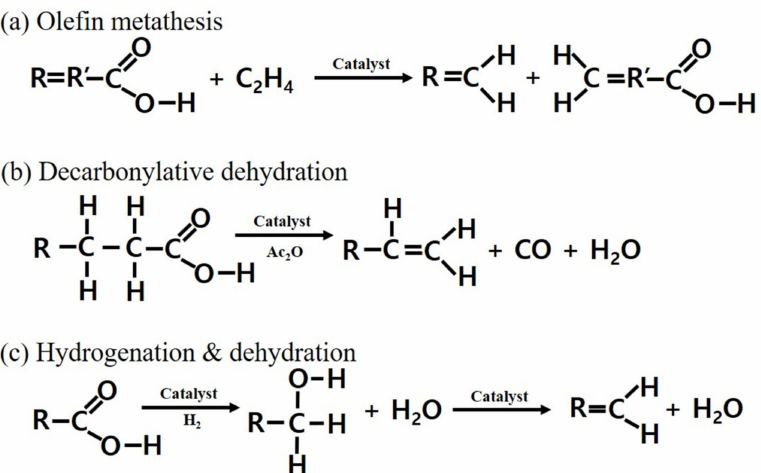
Figure 1. Various routes for bio-based LAO production; ( a ) olefin metathesis; ( b ) decarbonylative dehydration, and ( c ) hydrogenation and